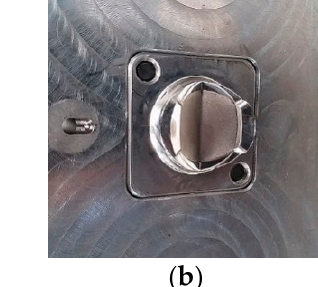
Figure 7. Injection molds for the ring of the inflow valve: ( a ) mold seat and ( b ) mold stamp.